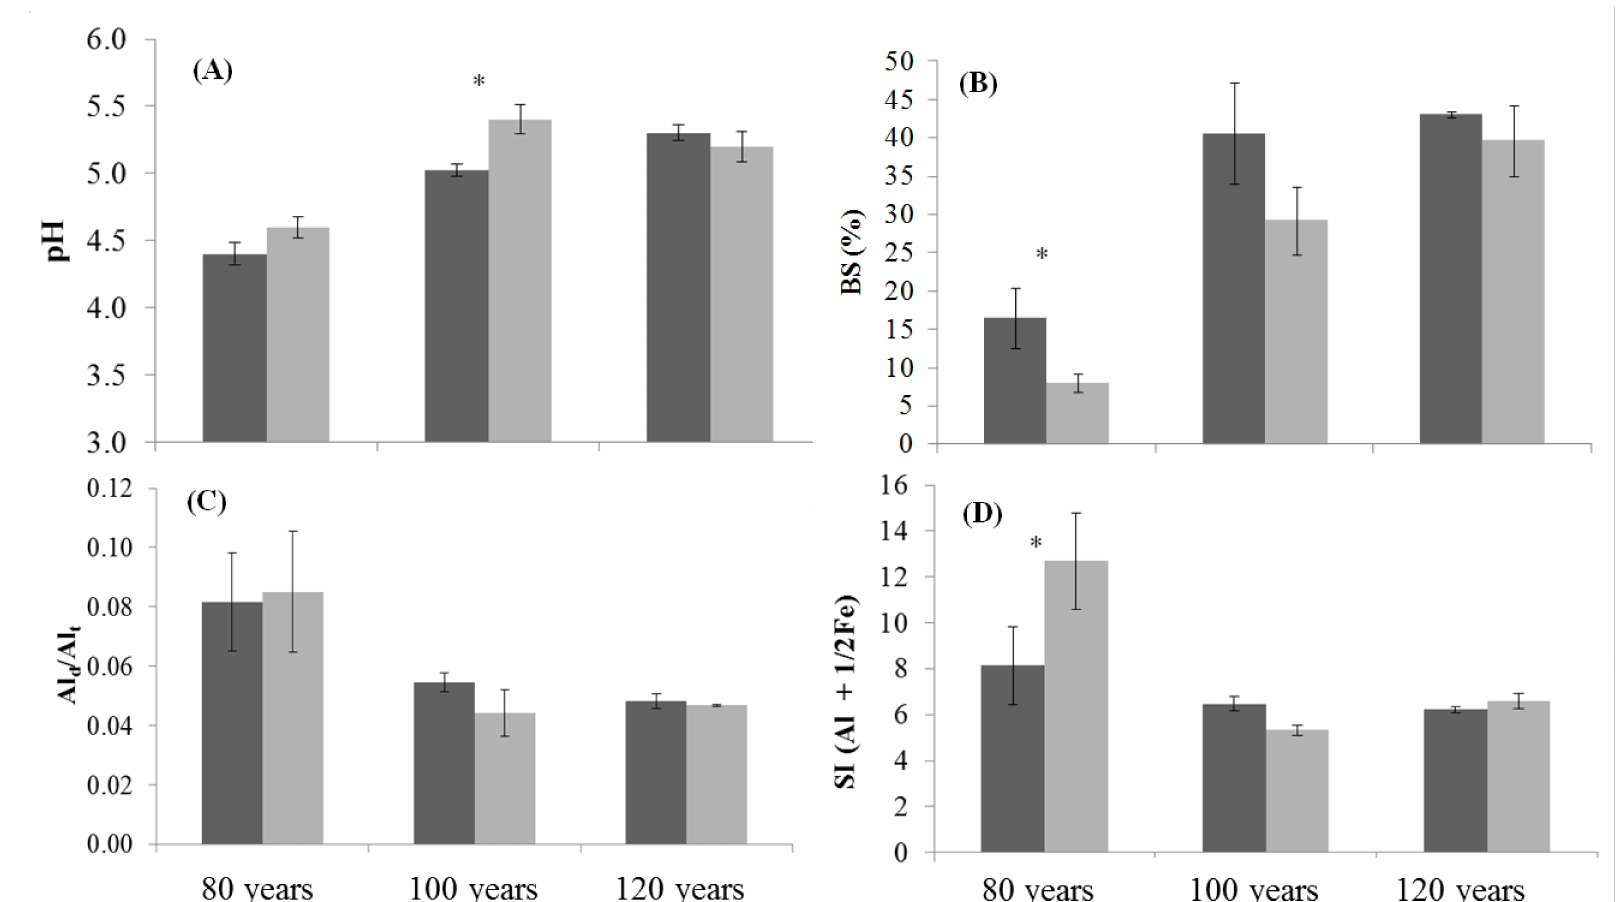
Figure 3. Chemical properties of epipedon (dark grey) and endopedon (light grey) along the Douglas fir stand chronosequence: soil pH ( A ), BS = base saturation ( B ), Ald/Alt = Pedogenic aluminium oxides to total aluminium ( C ), SI = spodicity index ( D ). Bars represent standard error, asterisk indicate significant difference (* p ≤ 0.05) between epipedon and endopedon at each stand age ( n =